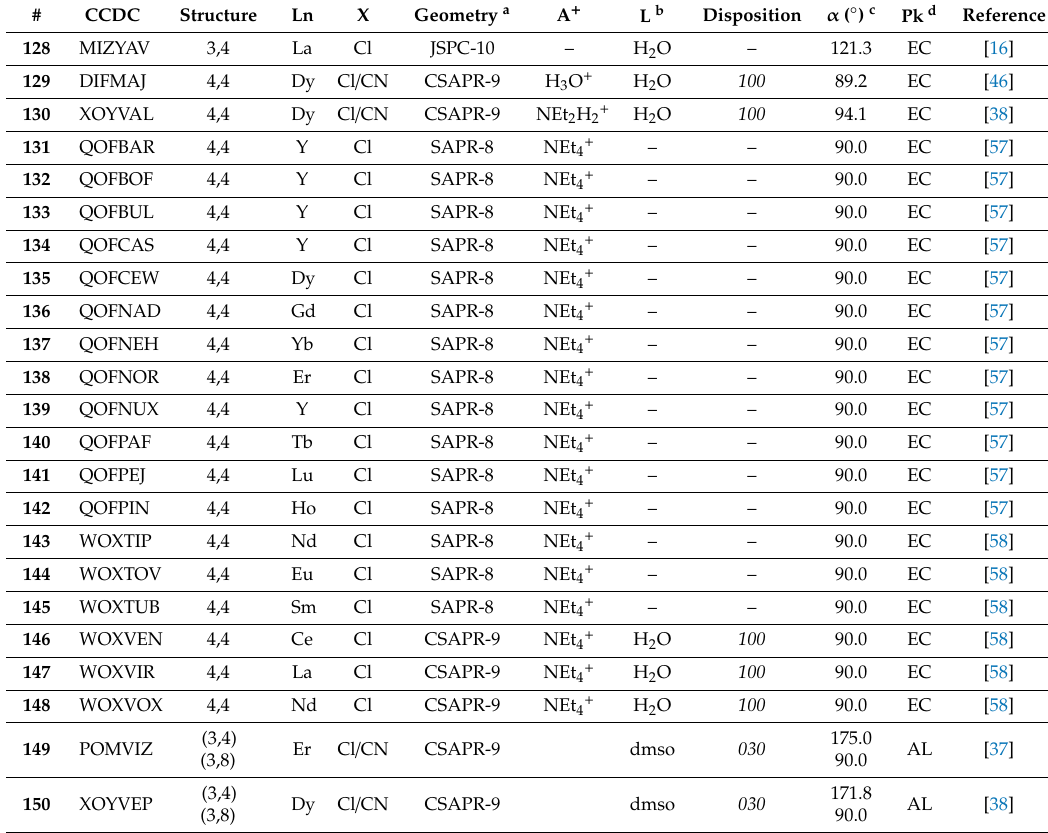
Table 6. Reported Ln-anilato complexes with 2D-(4,4), 2D-(3,4) and 2D-(3,4) + (3,8)